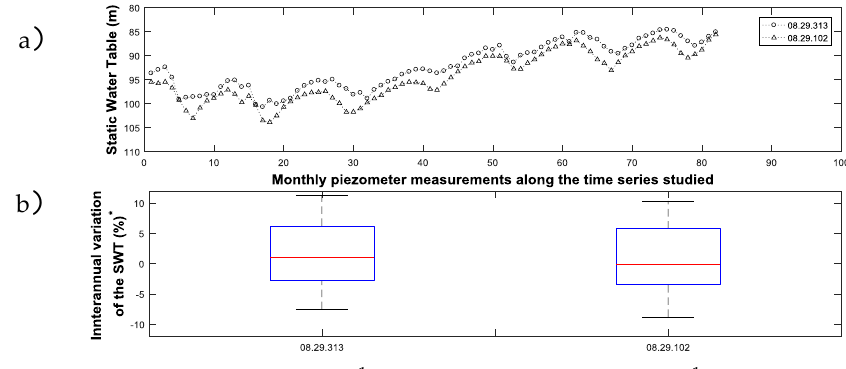
Figure 4. Static water table ( a ) and monthly interannual variation ( b ) for each piezometer in WUA A.